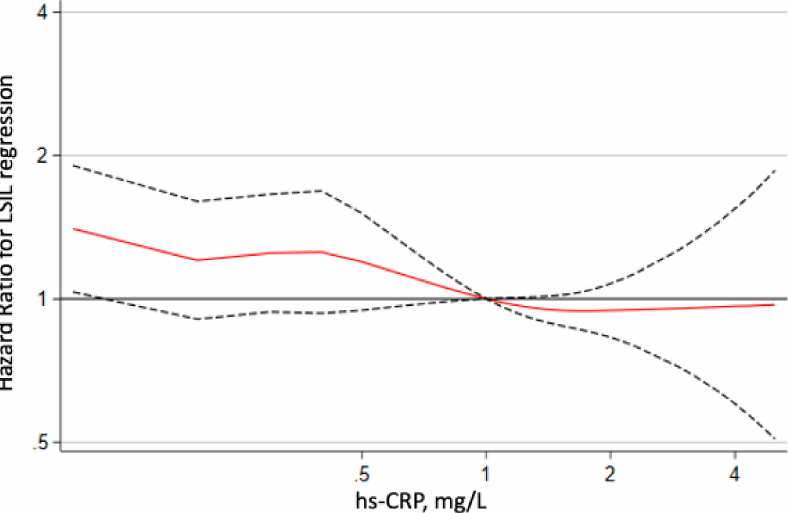
Figure 1. Multivariable-adjusted hazard ratios for low-grade squamous intraepithelial lesion (LSIL) regression. Curves represent adjusted hazard ratios for LSIL regression based on restricted cubic splines with knots at the 5th, 27.5th, 50th, 72.5th, and 95th percentiles of hs-CRP distribution. Models were adjusted for age, the year of a screening exam, smoking status, alcohol intake, married, HPV infection, history of diabetes, and education level. The red line represents adjusted hazard ratio, and the dashed lines represent the con fi dence intervals for the spline model. The horizontal black line corresponds to the normal reference hazard ratio of